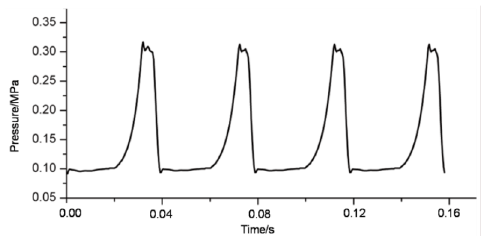
Figure 7. The pressure variation in the cylinder by the FSI model in four